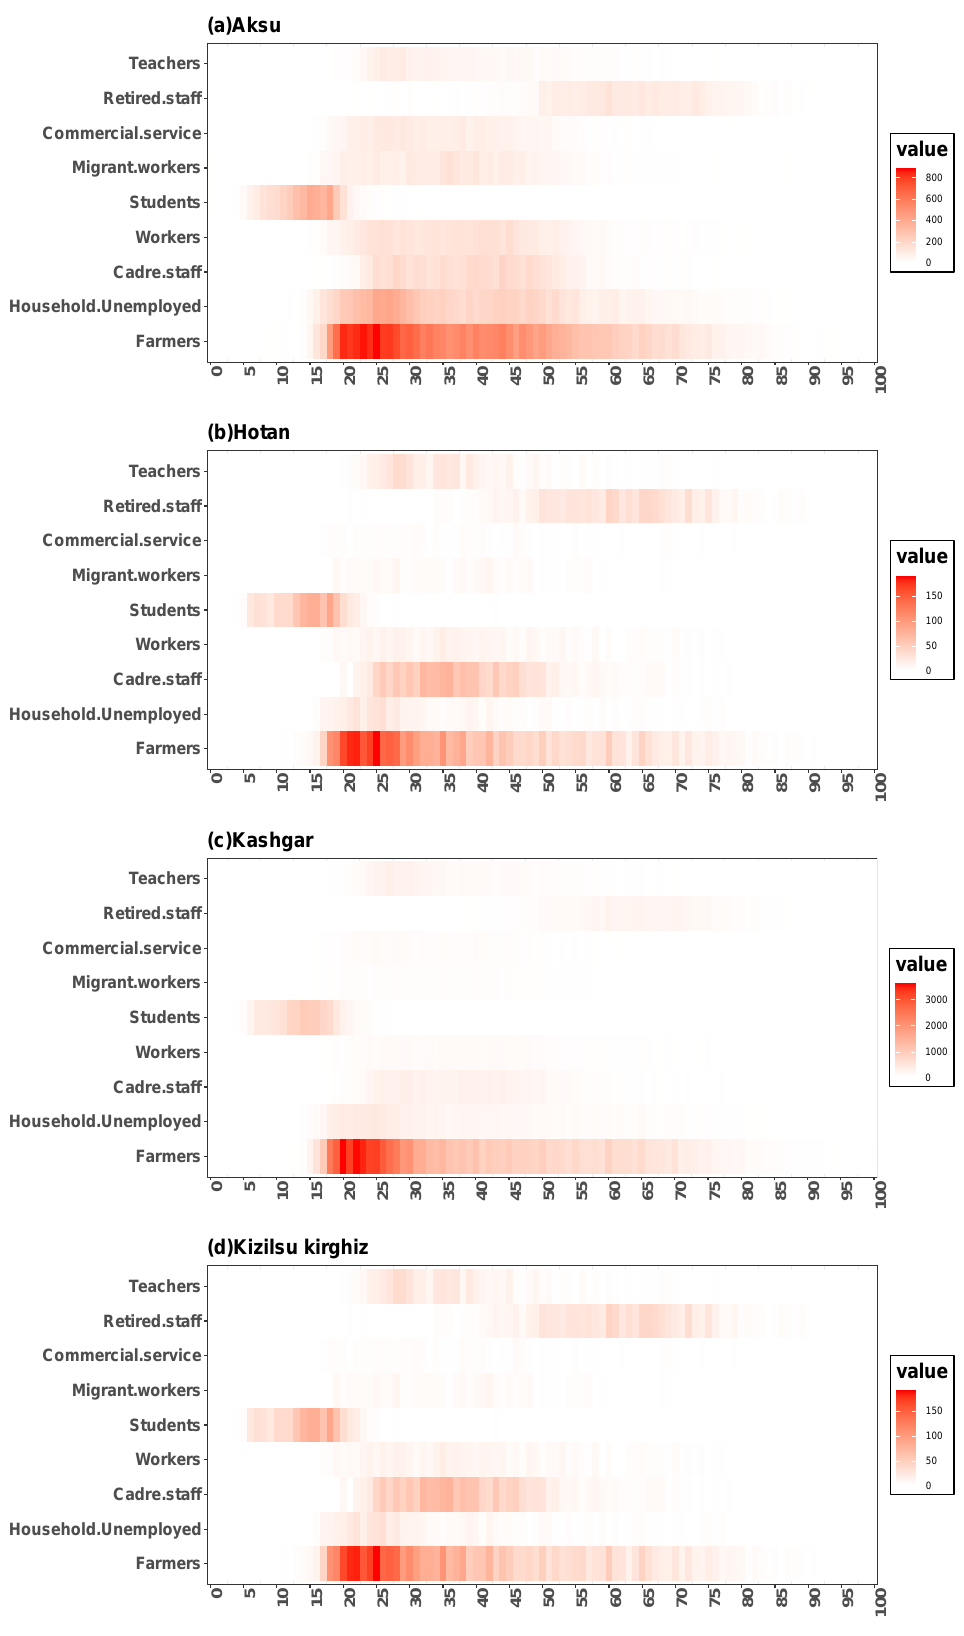
Figure 9. Age distribution of HB incidence in different occupations in four regions of